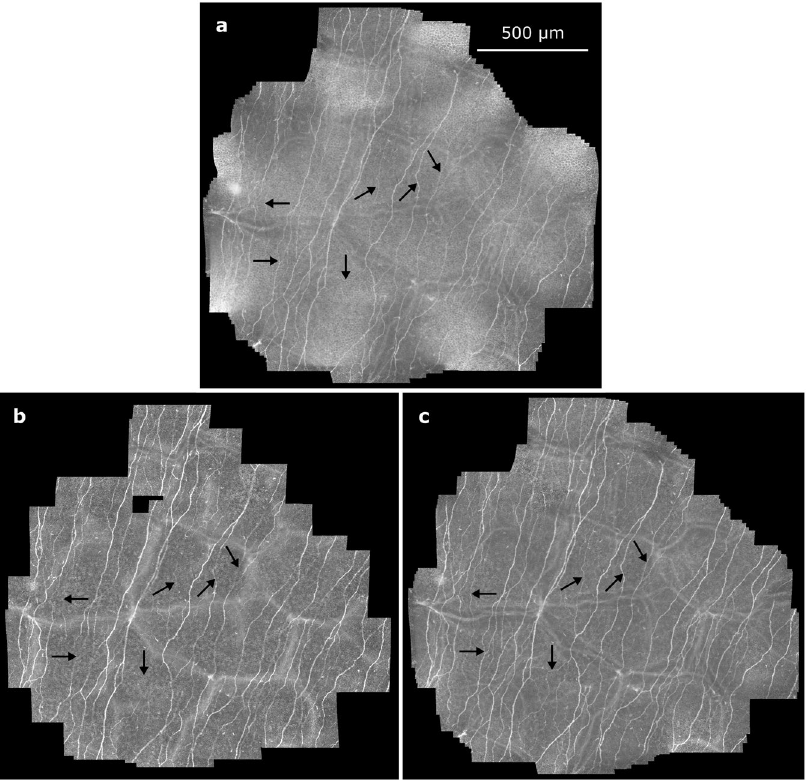
Figure 5. Mosaic images generated from a dataset (subject 8, examination E2); ( a ) mosaic image M1 using all 1245 images; ( b ) mosaic image M2 using the subset of 130 images acquired on the initial focus level; ( c ) mosaic image M3 using the subset of 610 images classified as SNP tissue. The arrows denote nerves that are visible in mosaic image M3 but not in M2.